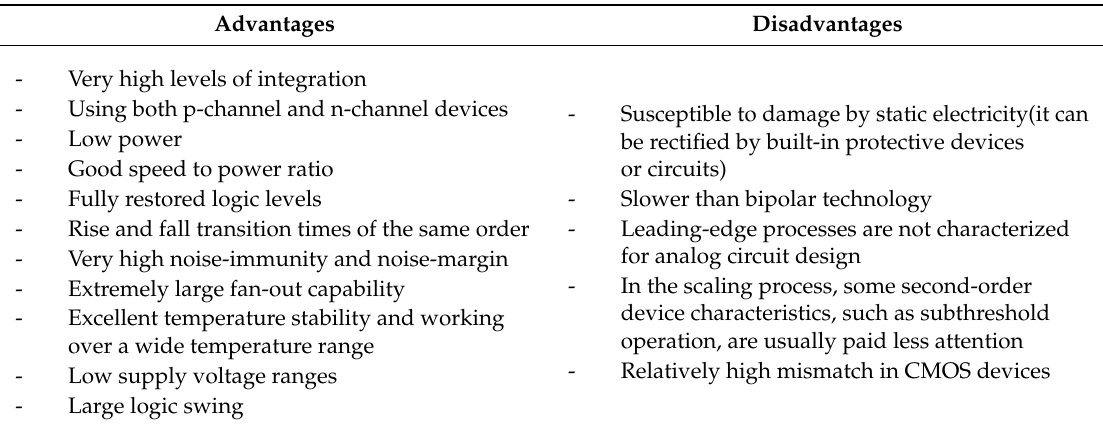
Table 2. Advantages and disadvantages of CMOS